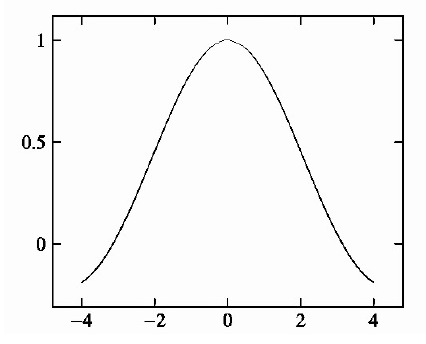
Figure 2. Gaussian distribution with 0